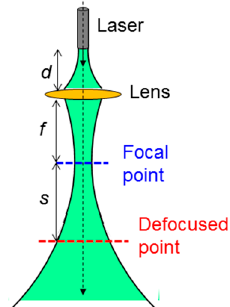
Figure 2. Schematic illustration of the setup for laser illumination onto cell samples. Cell wells were placed at the focal and defocused points for cell damage and perforation/preheating processes, respectively. Table 1. Laser conditions for generating the cell perforation, preheating, and damage effects. For the fs laser, the time-average values are given.